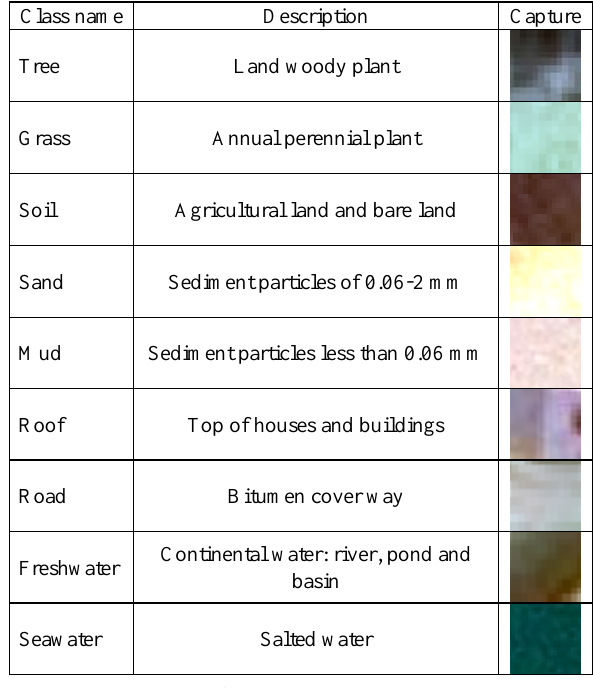
Table 2. Description of the nine Land Use / Land Cover classes